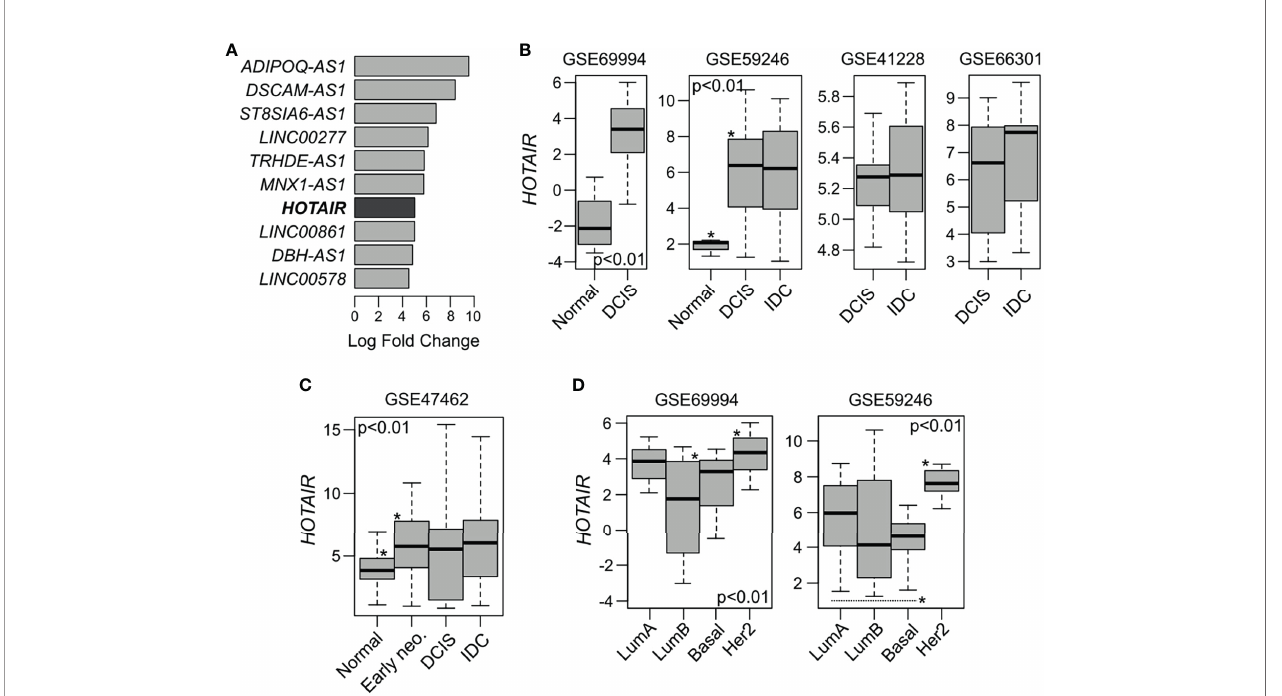
FIGURE 1 | HOTAIR expression in normal, pre-invasive and invasive breast samples. (A) Top ten most upmodulated lncRNAs in DCIS lesions compared with normal breast samples according to GSE69994 study (2). (B) In silico HOTAIR expression analysis among normal, DCIS and IBC samples obtained from four independent GEO dataset (2, 14 – 16). HOTAIR expression was signi fi cant upregulated in DCIS and IBC samples compared with normal samples (p < 0.01), while non-signi fi cant differences were observed between DCIS and IBC cases (p > 0.05). (C) HOTAIR expression analysis among normal and DCIS precursor lesions (early neo.) such as columnar cell lesions and atypical ductal hyperplasia, obtained from GSE47462 dataset (17). (D) HOTAIR expression analysis across DCIS intrinsic subtype obtained from two independent GEO datasets (2, 14). ANOVA or T-test were used to compare the HOTAIR expression among groups. *Statistical signi fi cance